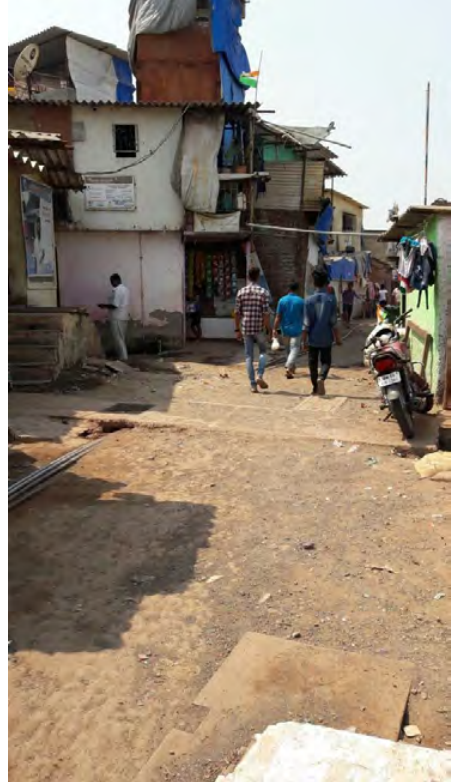
Figure 6. Gazdar Bandh slum site covered during field